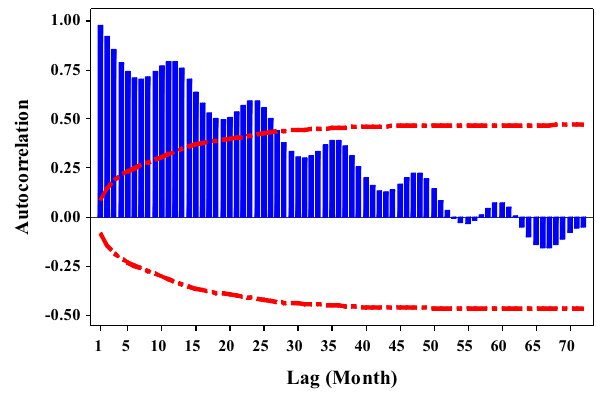
Fig. 5 Autocorrelation of lake level analyses for 70-month lag